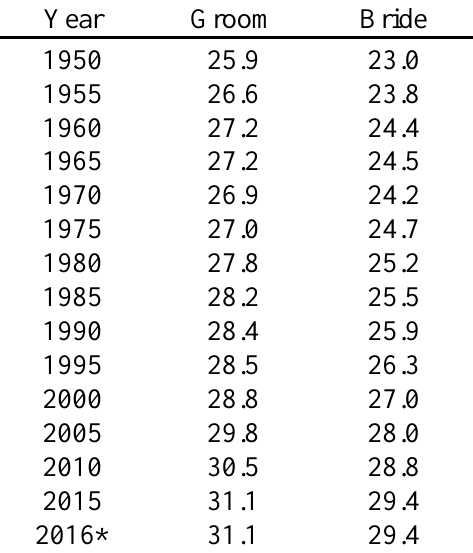
Mean Age of First